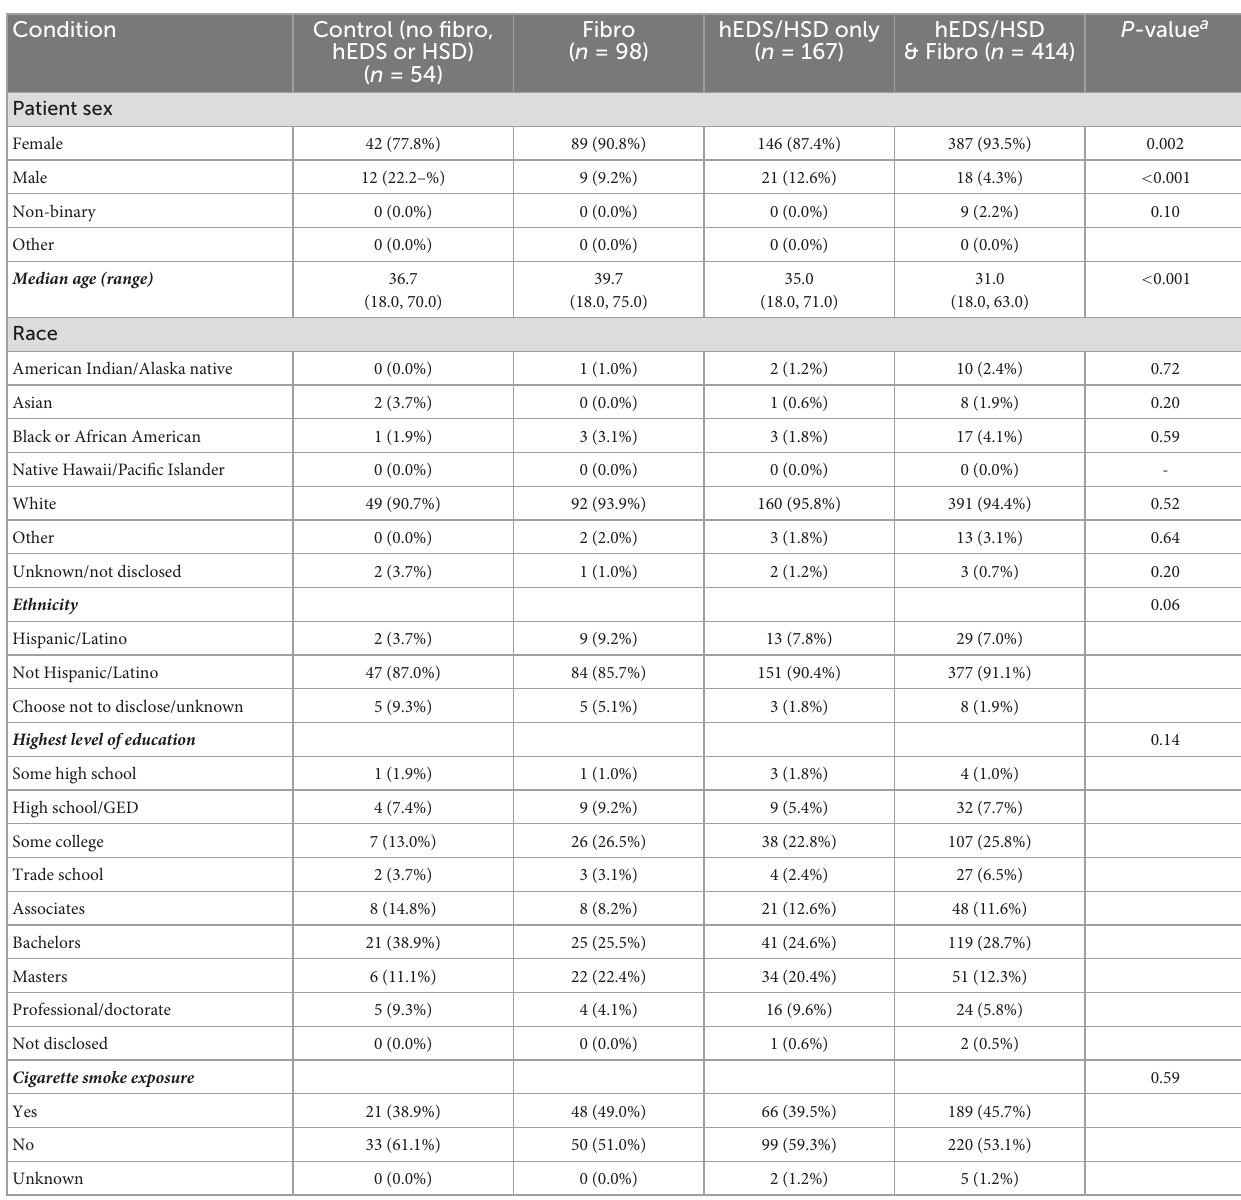
TABLE 1 Demographics of female and male patients diagnosed at the EDS Clinic ( n =